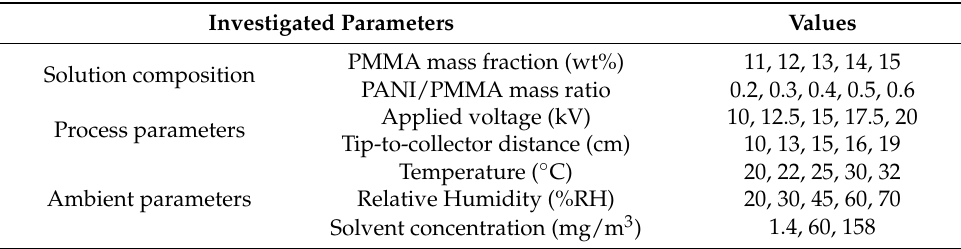
Table 1. Electrospinning parameter